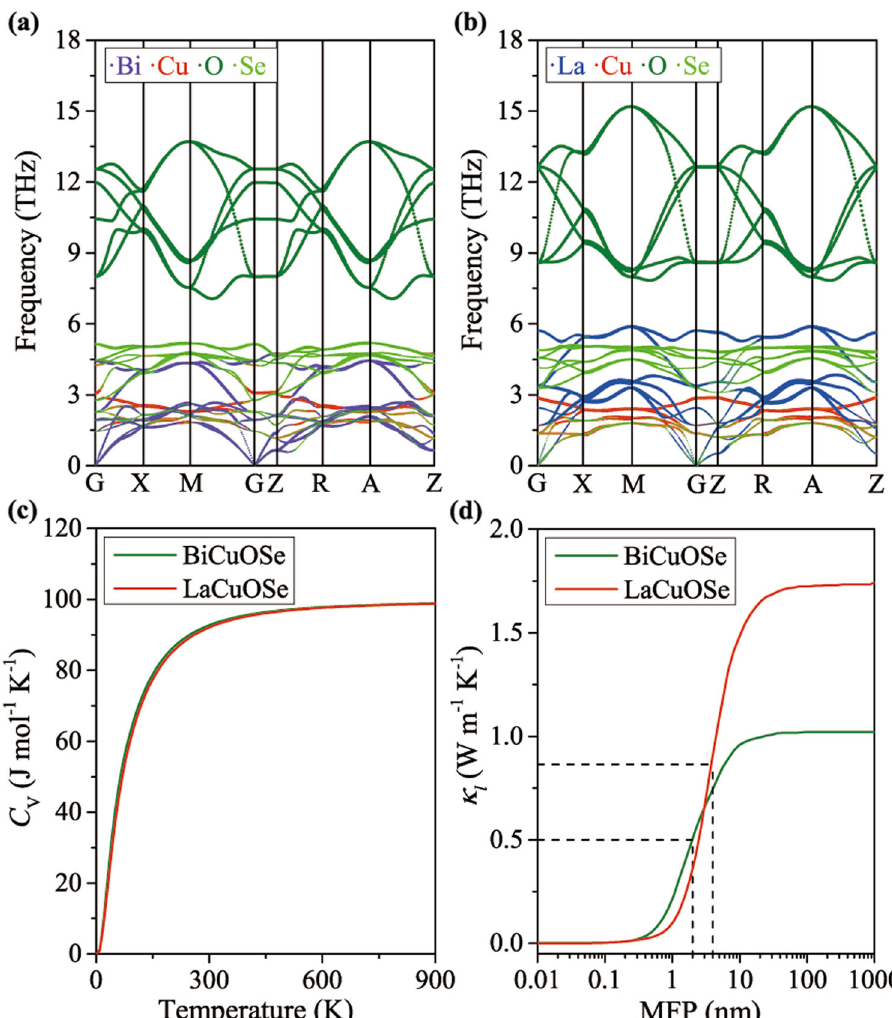
Fig. 6 Analysis of lattice thermal transport property. The phonon spectra ( a , b ) for BiCuOSe and LaCuOSe. c The heat capacities C V for BiCuOSe and LaCuOSe as a function of temperature. d The normalized integration of lattice thermal conductivities with respect to phonon mean free paths (PMFP) at 300 K for BiCuOSe and LaCuOSe.